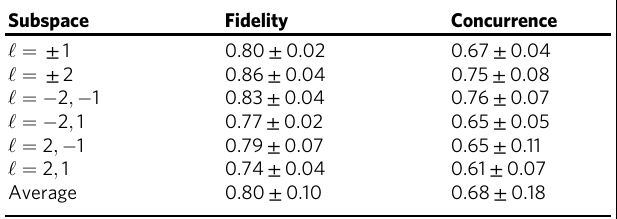
Table 1 Measures of entanglement Subspace Fidelity Concurrence